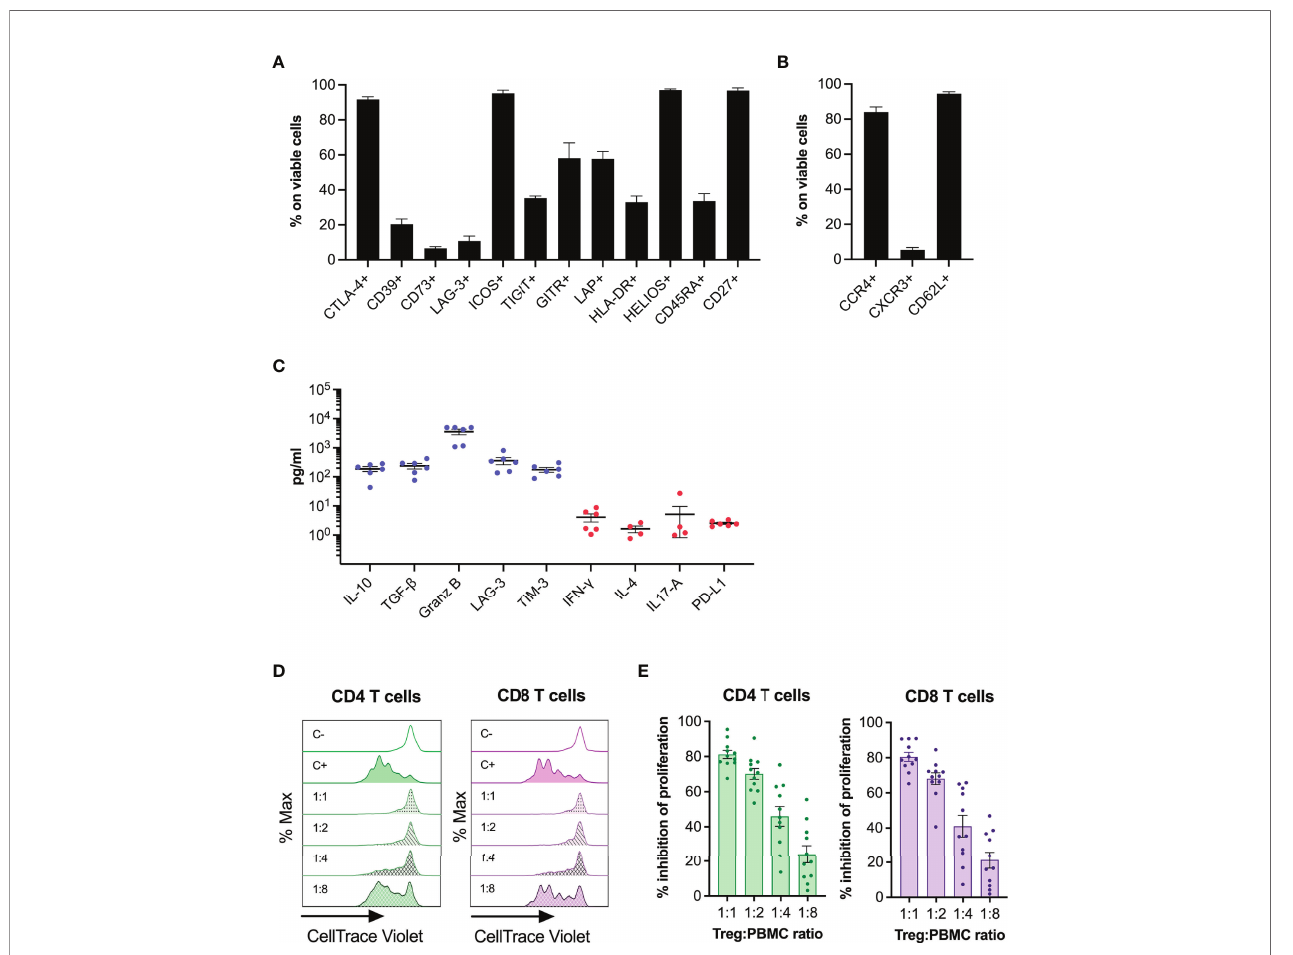
FIGURE 2 | Phenotype and functionality of thyTreg cell product. (A) Frequency of phenotypic and functionality markers within thyTreg cells (day 7). (B) Frequency of homing markers within thyTreg cells (day 7). (C) Quantitation of molecules secreted in day 7 thyTreg culture supernatants. Anti-in fl ammatory molecules in blue; proin fl ammatory molecules in red. (D) Representative fl ow cytometry histograms showing CD4 (green) and CD8 T (purple) cell proliferation as CellTrace Violet lost. C-, negative control of proliferation, PBMC cultured alone without stimulation; C+, positive control of proliferation, PBMC cultured alone with anti-CD3/anti-CD28 stimulation; 1:1 to 1:8, stimulated PBMC cultured with thyTreg cells at different thyTreg : PBMC ratios. (E) Summary of the suppressive capacity of thyTreg cells de fi ned as % inhibition of CD4 (green) and CD8 T (purple) cell proliferation at the indicated ratios. Graphs show mean ±